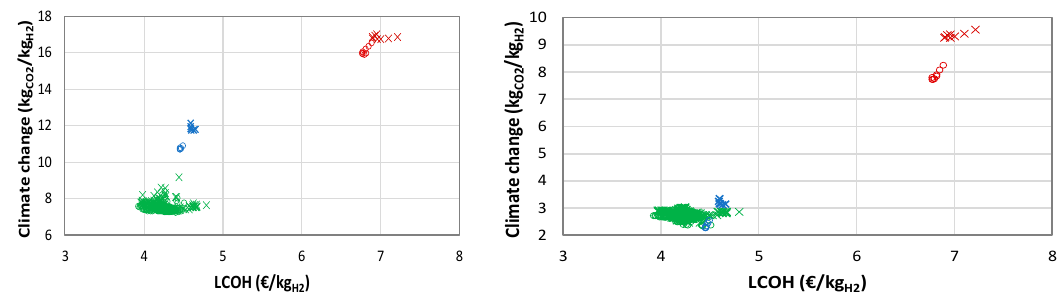
Figure 9. Comparison of the climate change impact of both scenario 1 (left) and scenario 2 (right) with respect to the cost of hydrogen.